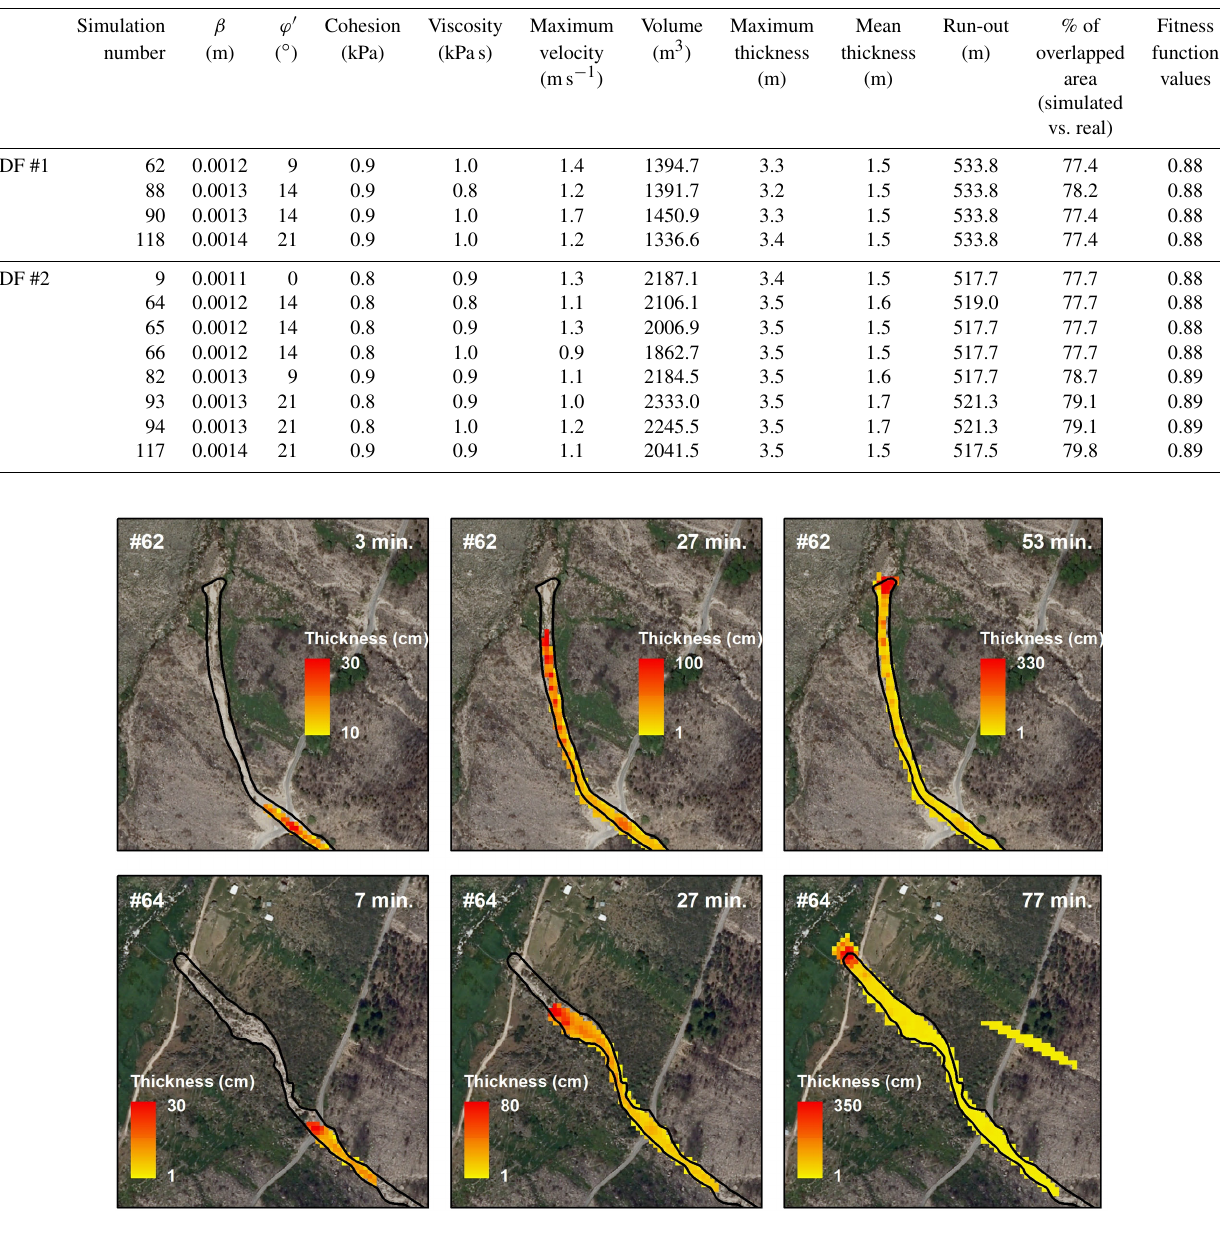
Figure 9. Temporal evolution of deposited material thickness, considering a simulation whose results agree with all three predefined criteria (Model run #62 for DF#1 and Model run #64 for